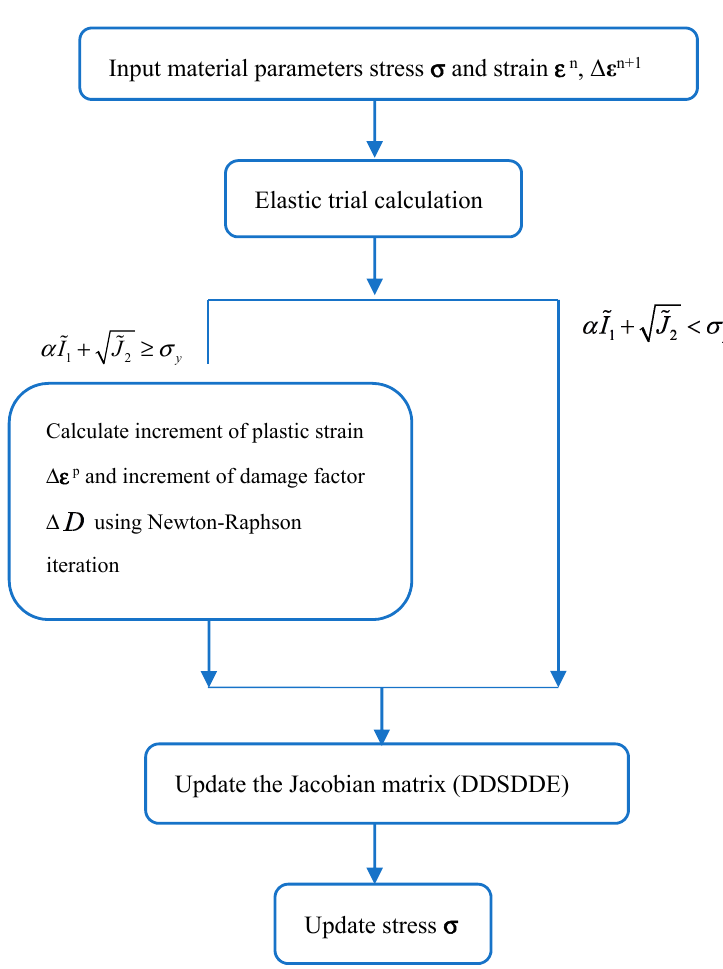
Figure 1. Flowchart of the plastic damage model of concrete. Table 1. Material properties of concrete.